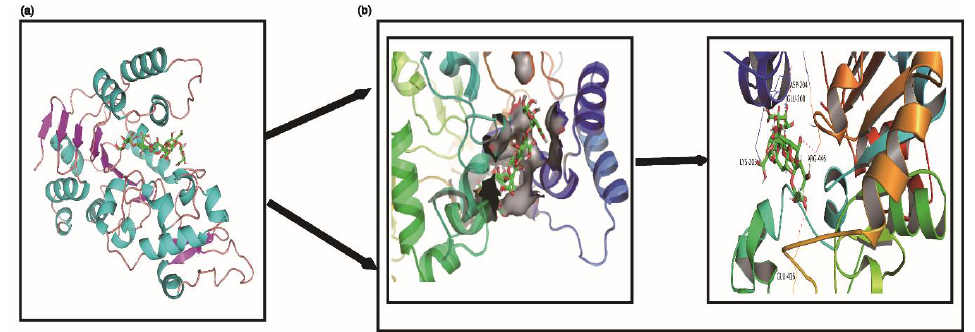
Figure 7. Molecular docking predicted the possible interaction between G6 and SIRT1 protein. ( a ) The electrostatic surface representation; ( b ) cartoon representation of the docking model of G6 binding to human SIRT1, using PyMOL1.8.